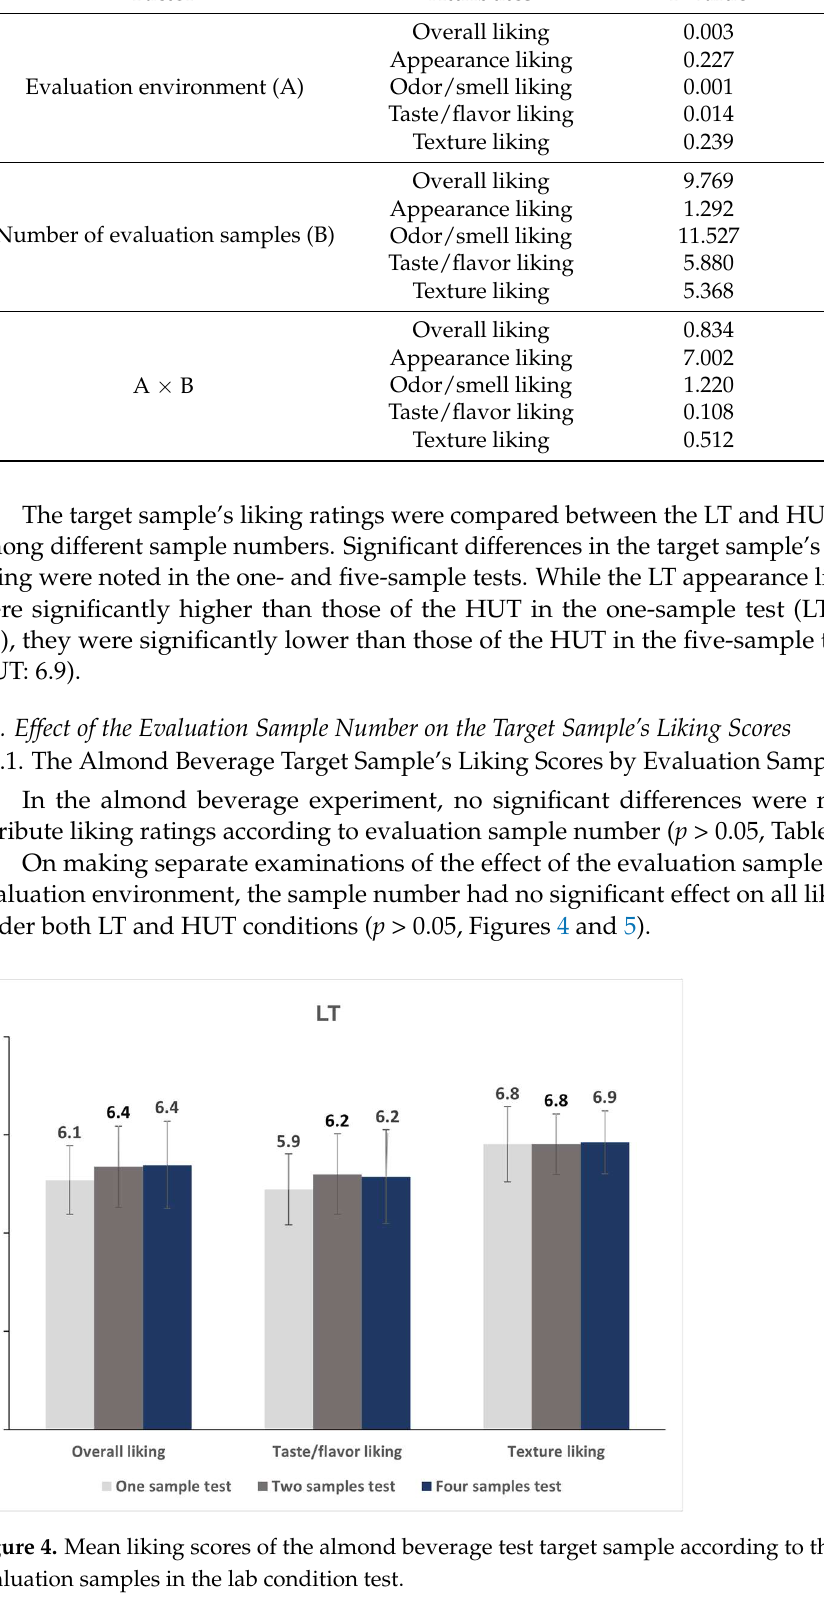
Figure 5. Mean liking scores of the almond beverage test target sample according to the number of evaluation samples in the home-used test condition. 3.3.2. The Vegan Ramen Target Sample’s Liking Scores by Evaluation Sample Number Significant differences in the overall, odor/smell, taste/flavor, and texture liking rat- ings of the target sample were observed when the evaluation sample number was varied ( p < 0.05, Table 4). The attributes that exhibited a significant sample number effect all yielded significantly higher scores when the target sample was evaluated alone than when it was evaluated with other samples (three- and five-sample tests). The target sample’s liking ratings for different sample numbers were as follows. The overall liking scores were 7.2 (one-sample test) > 6.4 (three-sample test) = 6.4 (five-sample test). The odor/smell liking scores were 7.1 (one-sample test) > 6.2 (five-sample test) ≥ 6.1 (three-sample test). The taste/flavor liking scores were 7.0 (one-sample test) > 6.5 (three-sample test) ≥ 6.4 (five-